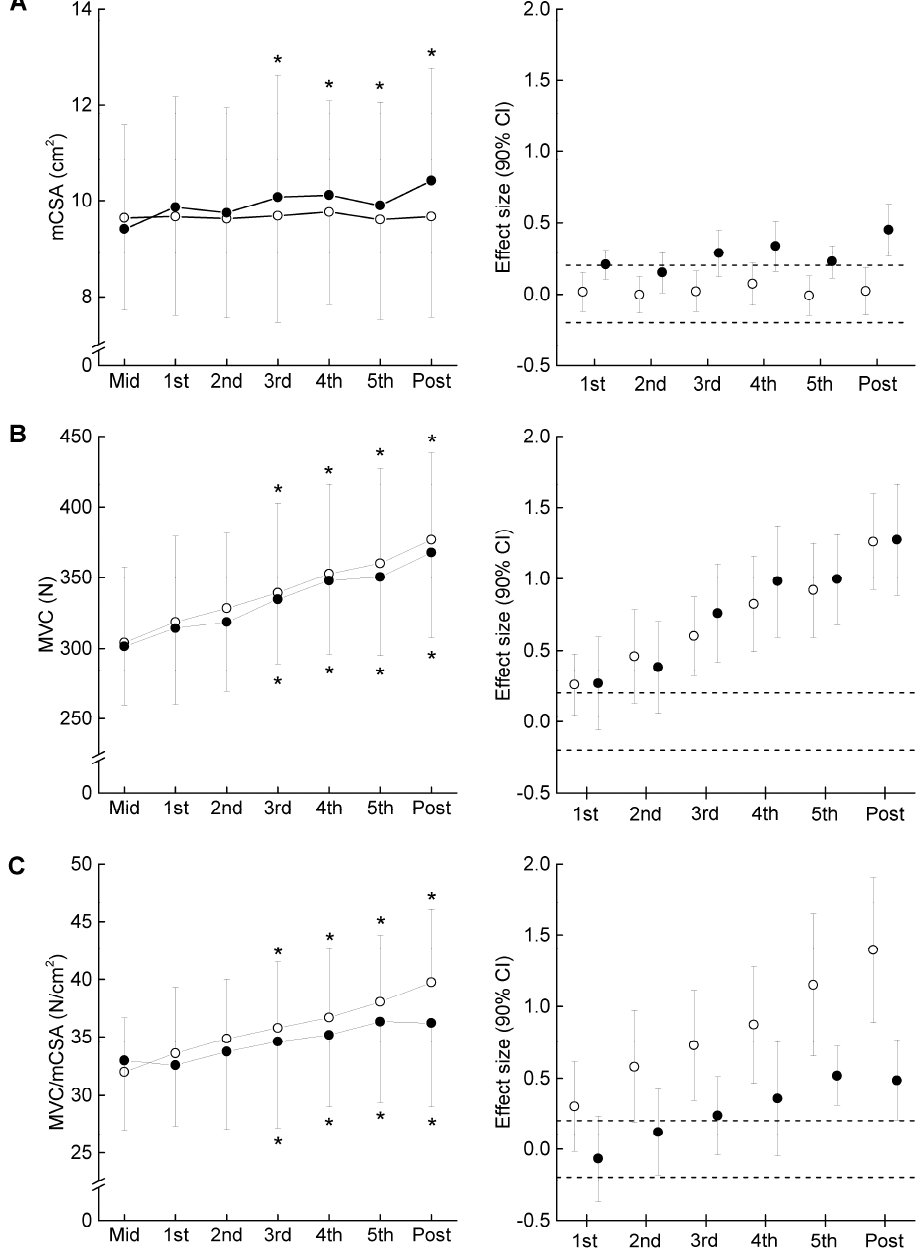
Figure 3. Time course of muscle cross-sectional area (mCSA) ( A ), maximal voluntary isometric contraction (MVC) ( B ), and MVC/mCSA ( C ) in the elbow flexors from Mid to Post (left panel). Effect size with 90% confidential interval (CI) at each measurement point compared to Mid (right panel). The filled and open circles denote COMB and ST. *, significant difference within the same arm compared to Mid. Dotted line is presented as ± 0.2 of effect size.